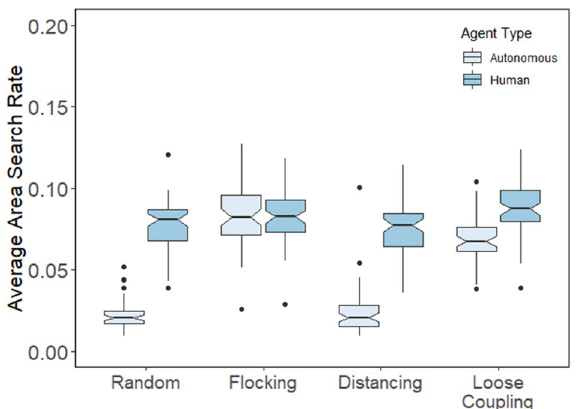
Figure 10. Area search rate averaged for each session and plotted as a function of movement type and agent type for human players and individual agents with